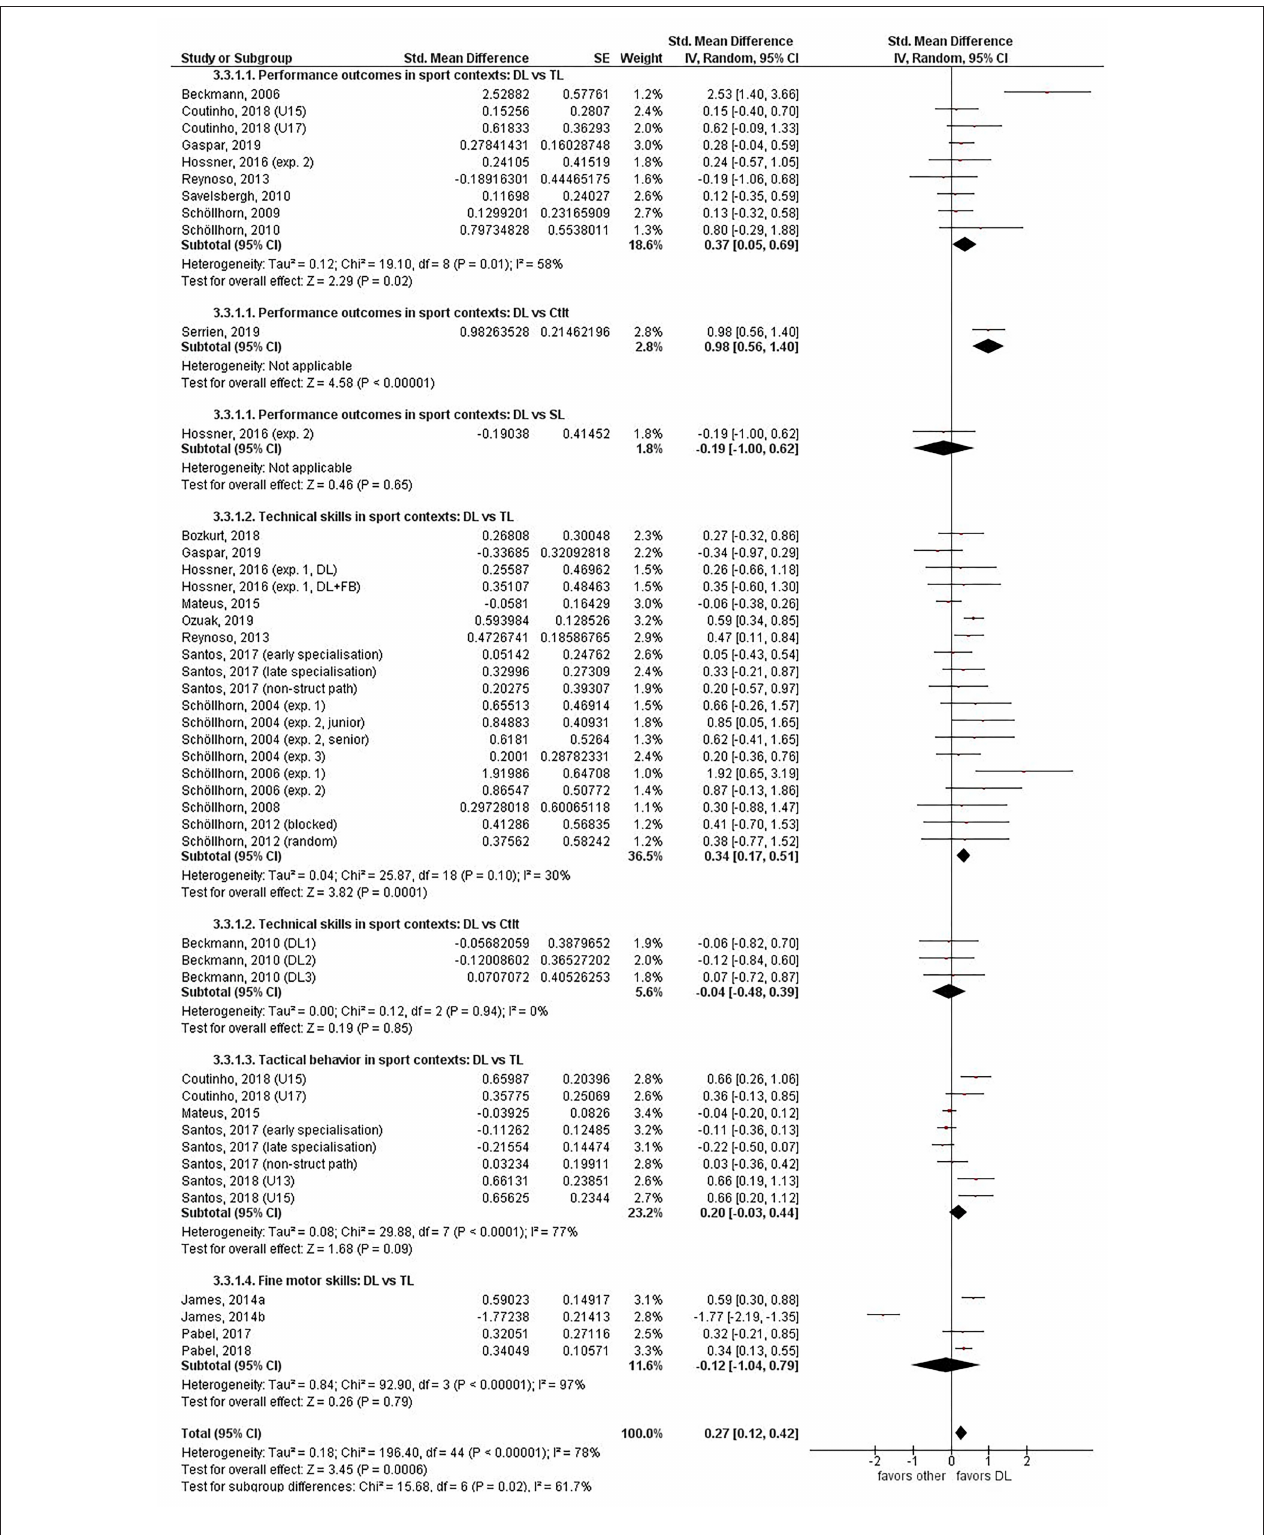
FIGURE 2 | Acquisition phase (post – pre). Forest plot for the effects of differential learning vs. other methods grouped by category of movement task. DL, differential learning; TL, traditional learning; CtIt, contextual interference; SL, structural learning.